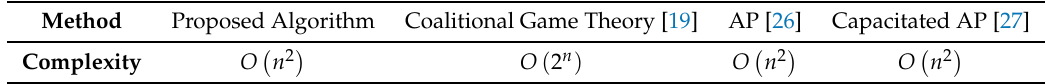
Table 2. Computational